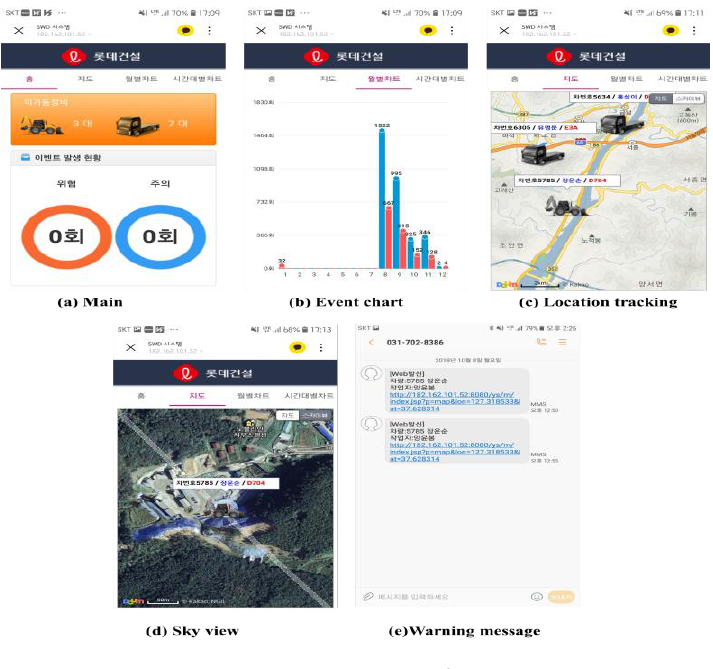
Figure 22. MAPS interface.